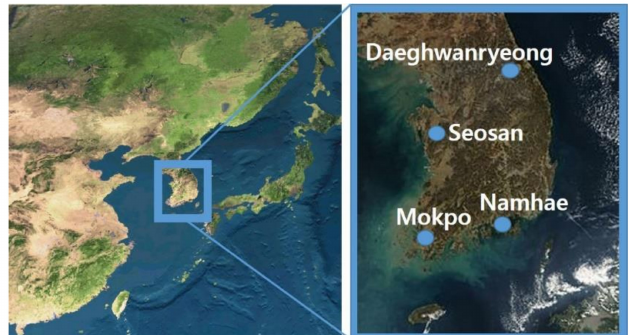
Figure 1. Location of study precipitation